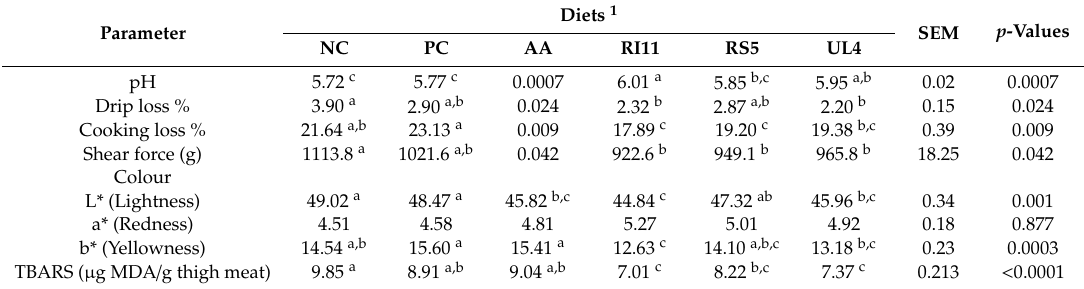
Table 3. Breast meat quality and thigh lipid peroxidation in heat-stressed broilers fed with three di ff erent postbiotics. Parameter